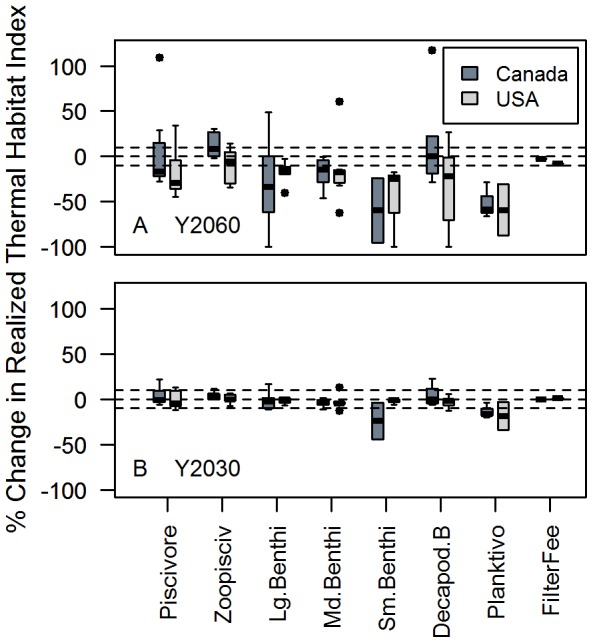
Change in Realized Thermal Habitat Index by functional group in Canada and USA.Panels depict results under the long-term (Y2060) (A) and short-term (Y2030) (B) scenarios. Functional group member species are listed in Table S1. Piscivore refers to piscivore. Zoopisciv refers to zoopiscivore, Lg.Benthi refers to large benthivores, Md.Benthi refers to Medium-sized benthivores, Sm.Benthi refers to small-sized benthivores. Decapod B refers to decapod benthivores, Planktivo refers to planktivores, FilterFee refers to filter feeders (scallop).